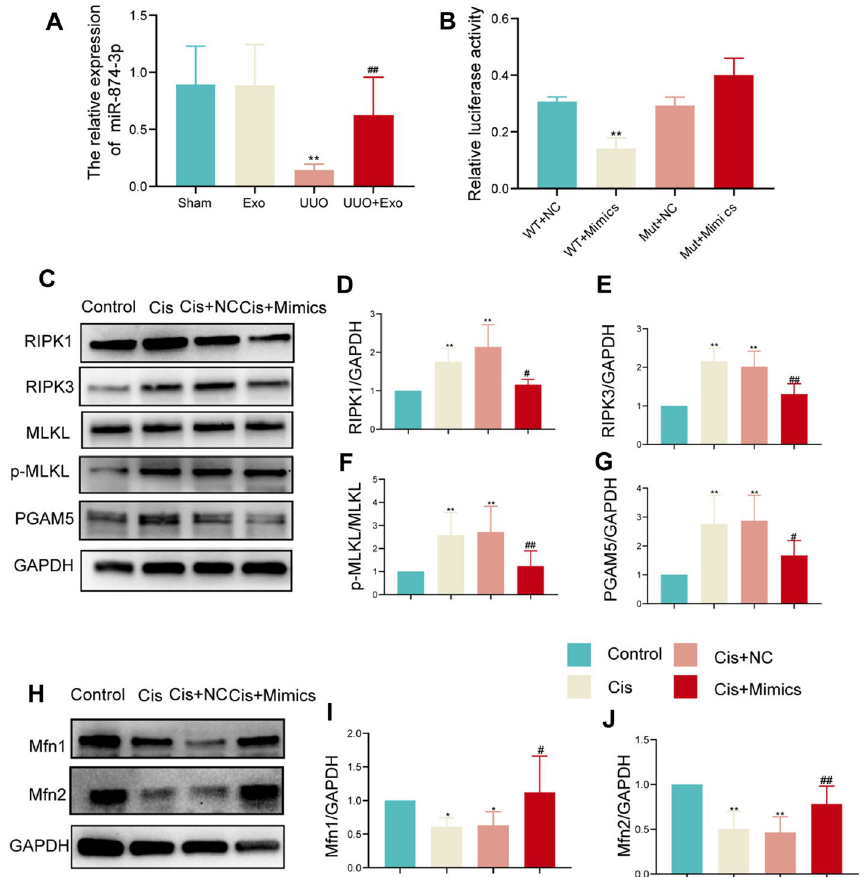
Fig. 7 Detection of miR-874-3p expression and its targeting to necroptosis. A Quantitative PCR detects the expression of miR-874-3p in each group in vivo. ** p < 0.01, compared with sham group; ## p < 0.01, compared with UUO group. B Detection of miR-874-3p targeting RIPK1 by dual-luciferase reporter gene assay. ** p < 0.01, compared with WT NC group. C Western blot of necroptosis-related markers (RIPK1, RIPK3, MLKL, p-MLKL, + and PGAM5) in each group. D – G Relative expression of necroptosis-related markers detected by western blot. * p < 0.05, ** p < 0.01, compared with control group; # p < 0.05, ## p < 0.01, compared with cisplatin (Cis) group. H Western blot of Mfn1 and Mfn2 in each group. I , J Relative expression of Mfn1 and Mfn2 detected by western blot. * p < 0.05, ** p < 0.01, compared with control group; # p < 0.05, ## p < 0.01, compared with Cis